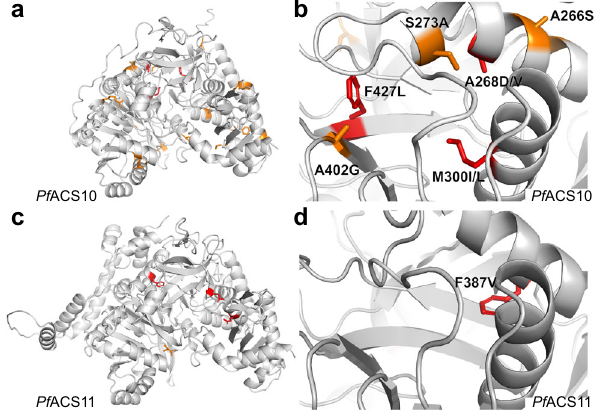
Fig.4|Resistance-conferringmutationsandnaturallyarisingvariantsoccurin the predicted fatty acid binding pockets of Pf ACS10 and Pf ACS11. a AlphaFold model of the structure of Pf ACS10. b Mutations conferring resistance to MMV665924 and MMV897615 occur within the fatty acid binding pocket of Pf ACS10. The position of the resistance-conferring mutations M300I, F427L and A268D/V are depicted in red. Several non-synonymous genetic variants in the MalariaGen Pf3k database with high minor allele frequency also occur within the fatty acid binding pocket (A402G, S273A, A266S). c AlphaFold model of ACS11. d The F387V mutation (depicted in red) is localized to the predicted fatty acid bindingpocketofthe Pf ACS11protein.Aminoacidpositionswithnon-synonymous genetic variants in the MalariaGen Pf3k (www.malariagen.net/pf3k) database with minor allele frequency >0.01 are depicted in orange (Fig. 3 and Supplementary 4). Resistance-associated mutations are depicted in red.